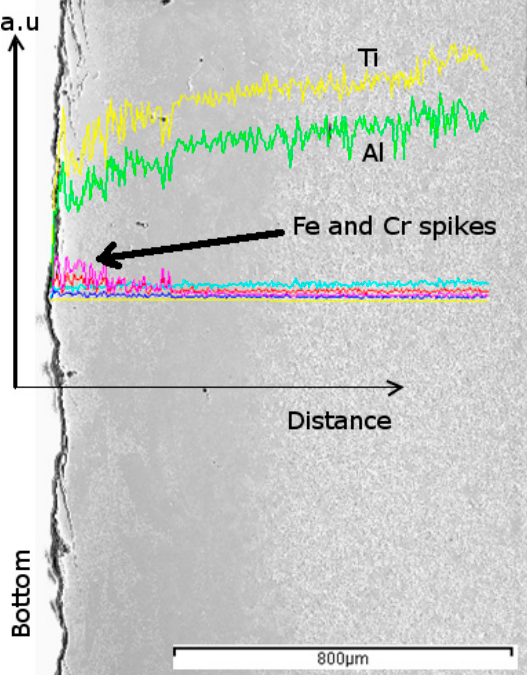
Figure 6. Scanning electron microscopy–Energy dispersive X-ray spectroscopy ( SEM–EDS) linescan showing diffusion of elements from the substrate plate in to the built part (Yellow—Ti, Green—Al, Pink—Fe, Red—Cr, Cyan—Nb, Blue—Ni).